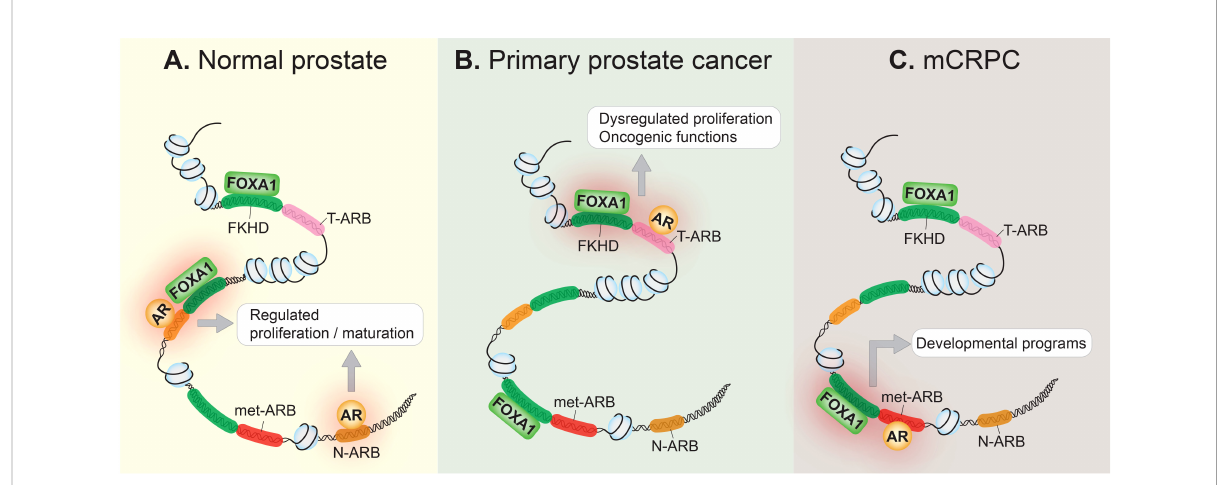
FIGURE 1 The AR cistrome is reprogrammed during prostate cancer onset and progression. (A) In the normal prostate epithelium, the AR occupies its normal cistrome, the collective of normal AR binding sites (N-ARB), and controls the AR signaling axis to regulate cellular proliferation, and the maturation of the prostate gland. Pioneer transcription factors, such as FOXA1 which binds to the forkhead (FKHD) binding motif, contribute to AR-regulated transcription. (B) In primary prostate cancer, the AR is redirected to a distinct set of tumor-associated AR binding sites (T-ARB), resulting in aberrant cellular proliferation, transforming the AR into an oncogene. This may be due to genetic or epigenetic disturbances that disrupt the homeostatic relationship between FOXA1 and the AR in normal prostate epithelium. (C) In metastatic castration-resistant prostate cancer (mCRPC), the AR cistrome is further reprogrammed, and AR binds to metastatic AR-binding sites (met-ARB), activating decommissioned developmental programs, seemingly to drive metastasis. FOXA1 binding at these metastatic-associated binding sites precedes the development of